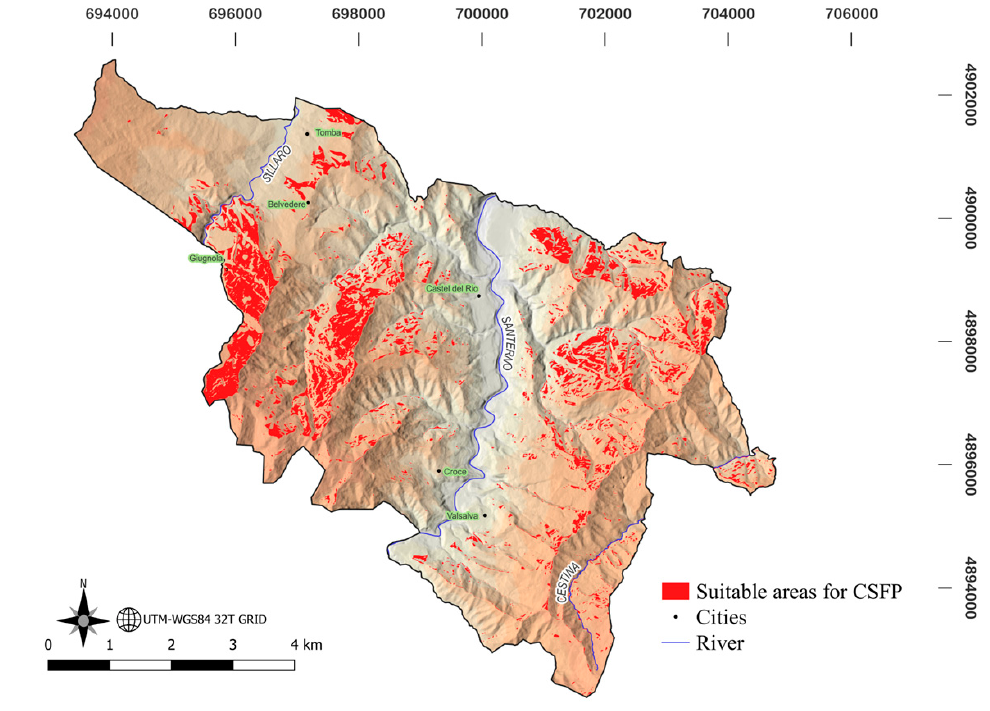
Figure 5. Suitability map for chestnut stands for fruit production (CSFP) for Castel del Rio, Emilia-Romagna Region, Italy.